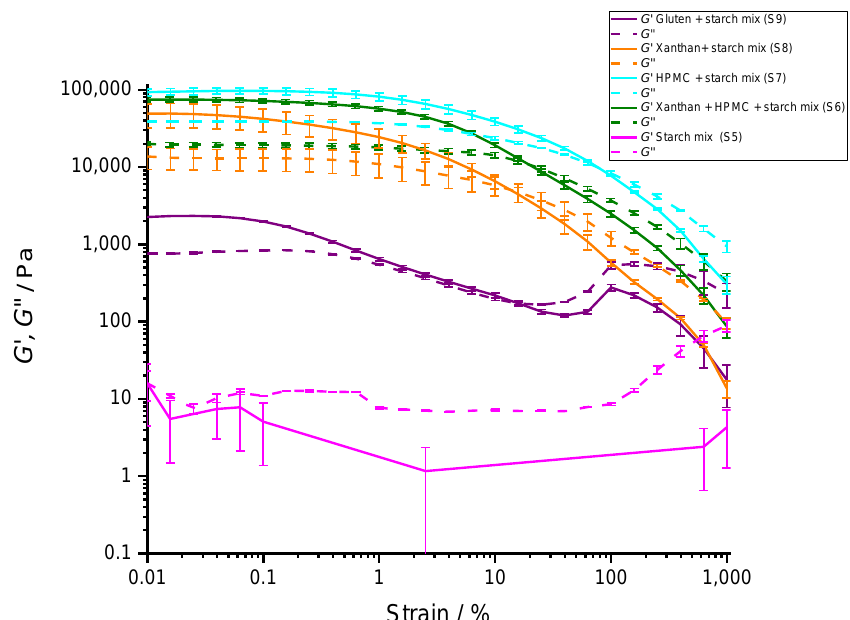
Figure 6. Rheology: Oscillatory amplitude tests performed on samples of individual hydrocolloids aqueous solutions. Storage ( G ′ , -----) and loss modulus ( G ″ , - - - -) of 8% xanthan gum in water (or- ange line, S11), 8% HPMC in water (blue line, S10) and 8% gluten in water (purple line, S12). The lines represent averages of three independent experiments ( n = 3) and the error bars correspond to SD. All concentrations are given as ( w / w ).